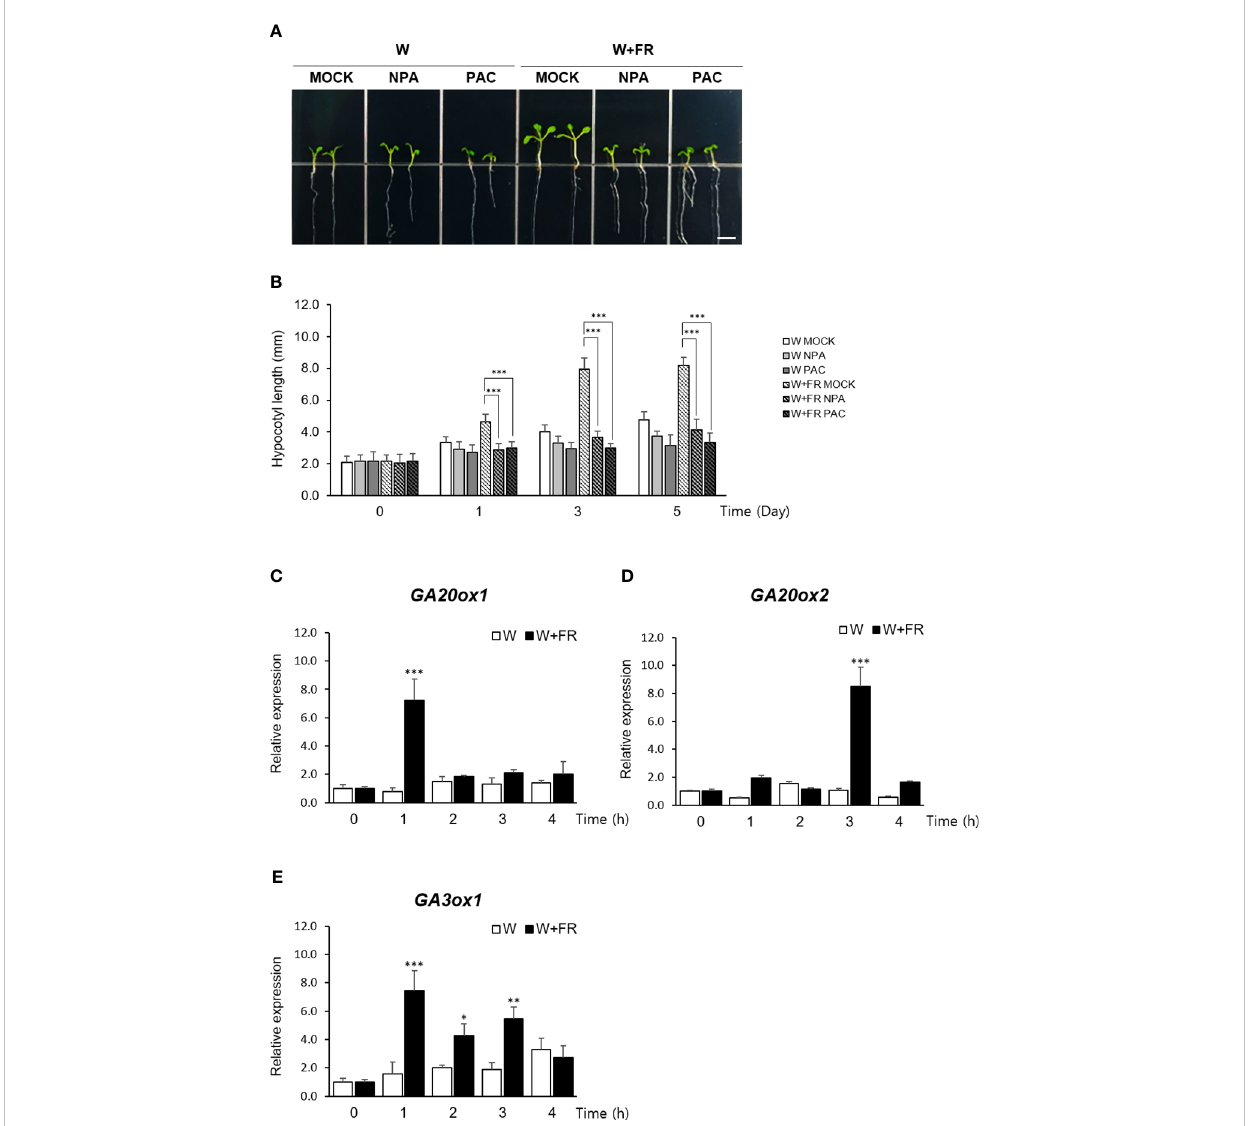
FIGURE 1 Expression of GA biosynthetic genes under the shade condition. (A) Effects of auxin transport inhibitor NPA or GA biosynthetic inhibitor PAC on hypocotyl lengths of Arabidopsis thaliana under shade condition was observed. Light condition was as follows: W, continuous white light; W+FR, continuous white light supplemented with far-red light. Five-day-old seedlings grown under either W or W+FR condition were treated with MOCK, NPA, or PAC for 5 days on 1/2 MS media. Scare bar, 5 mm. (B) Hypocotyl lengths were measured at the indicated times: 0 day, 1 day, 3 days, and 5 days after NPA or PAC treatment. Data shown are mean ± SD (n > 15). (C – E) Expression of GA20ox1 (C) , GA20ox2 (D) , and GA3ox1 (E) under W and W+FR in time course using 7-day-old seedlings were analyzed by real-time quantitative PCR. Results are representative of three